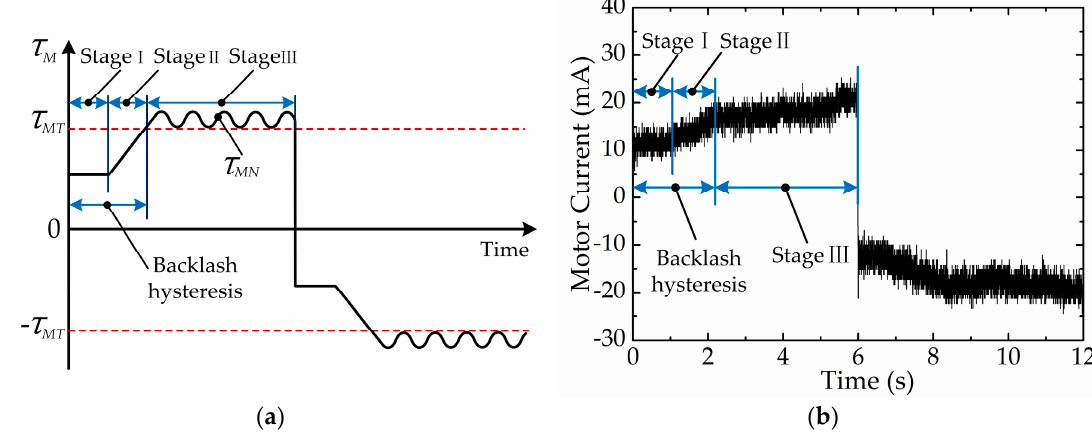
Figure 6. Varying patterns of motor driving moment and motor current: ( a ) varying patterns of motor driving moment; ( b ) varying patterns of motor current.